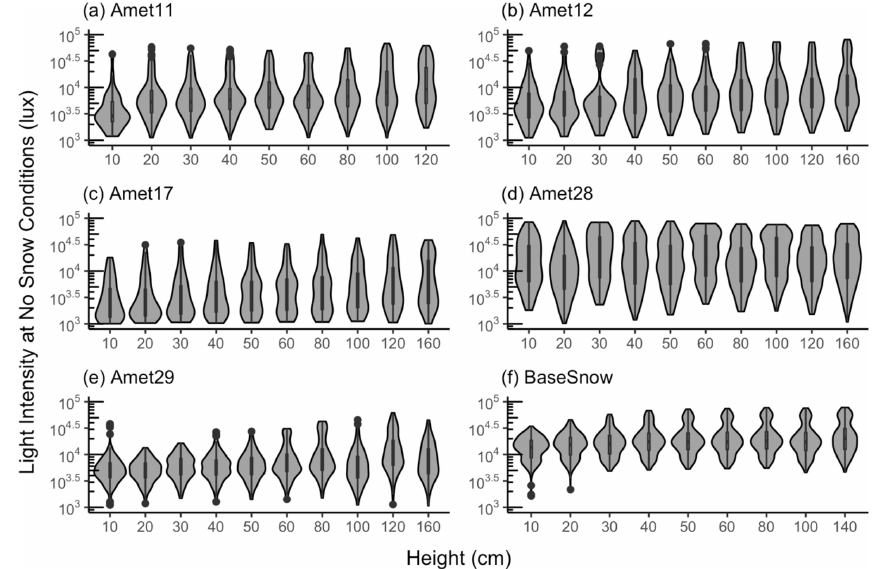
Figure 4. Violin plot (rotated kernel density) showing the probability density and distribution of daily maximum light intensities (logarithmic scale) when the daily maximum temperature is above 0.5 ◦ C at (a) Amet11, (b) Amet12, (c) Amet17, (d) Amet28, (e) Amet29 and (f) BaseS- now. Minimum values were used as the individual logger thresholds for the change-point analysis and pooled thresholds were used for the range of thresholds used in the interpolated